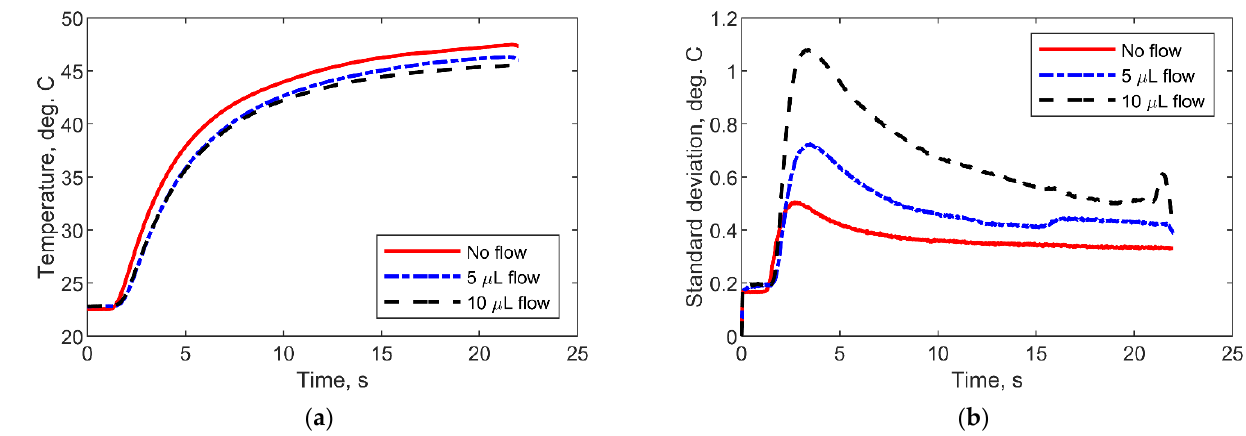
Figure 6. ( a ) The average temperature of the liquid mixture loaded into the microwell for the three measurement scenarios. ( b ) The standard deviation of the mixture temperature in the microwell for the three measurement scenarios.